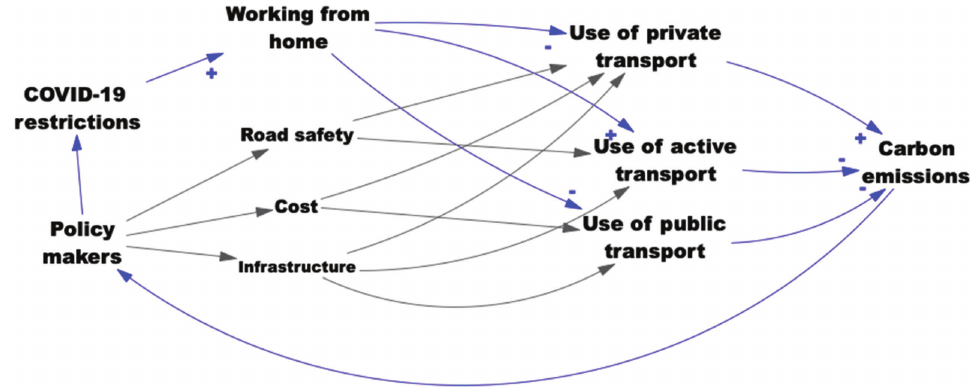
Figure 1 Working from home concept map. arrows represent causal relationships, with blue arrows representing relationships illustrated by data. (Grey arrows represent variables and links that are known to be important but for which no data was sought for this